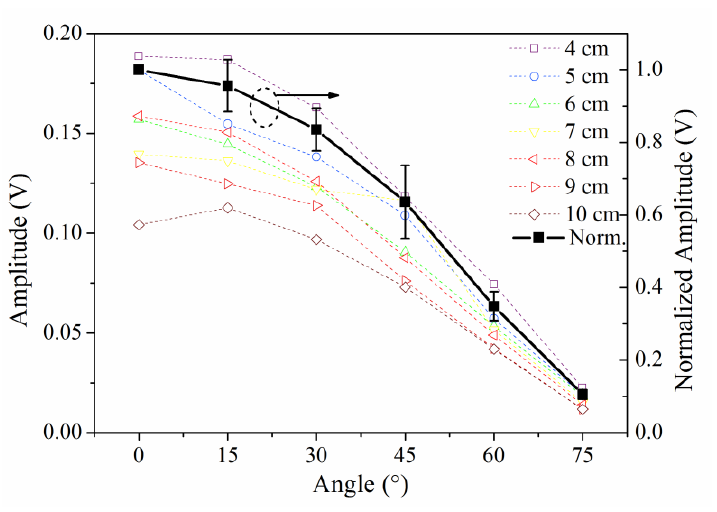
Figure 6. After normalization, the sensitivity and the angle show cosine relation in area